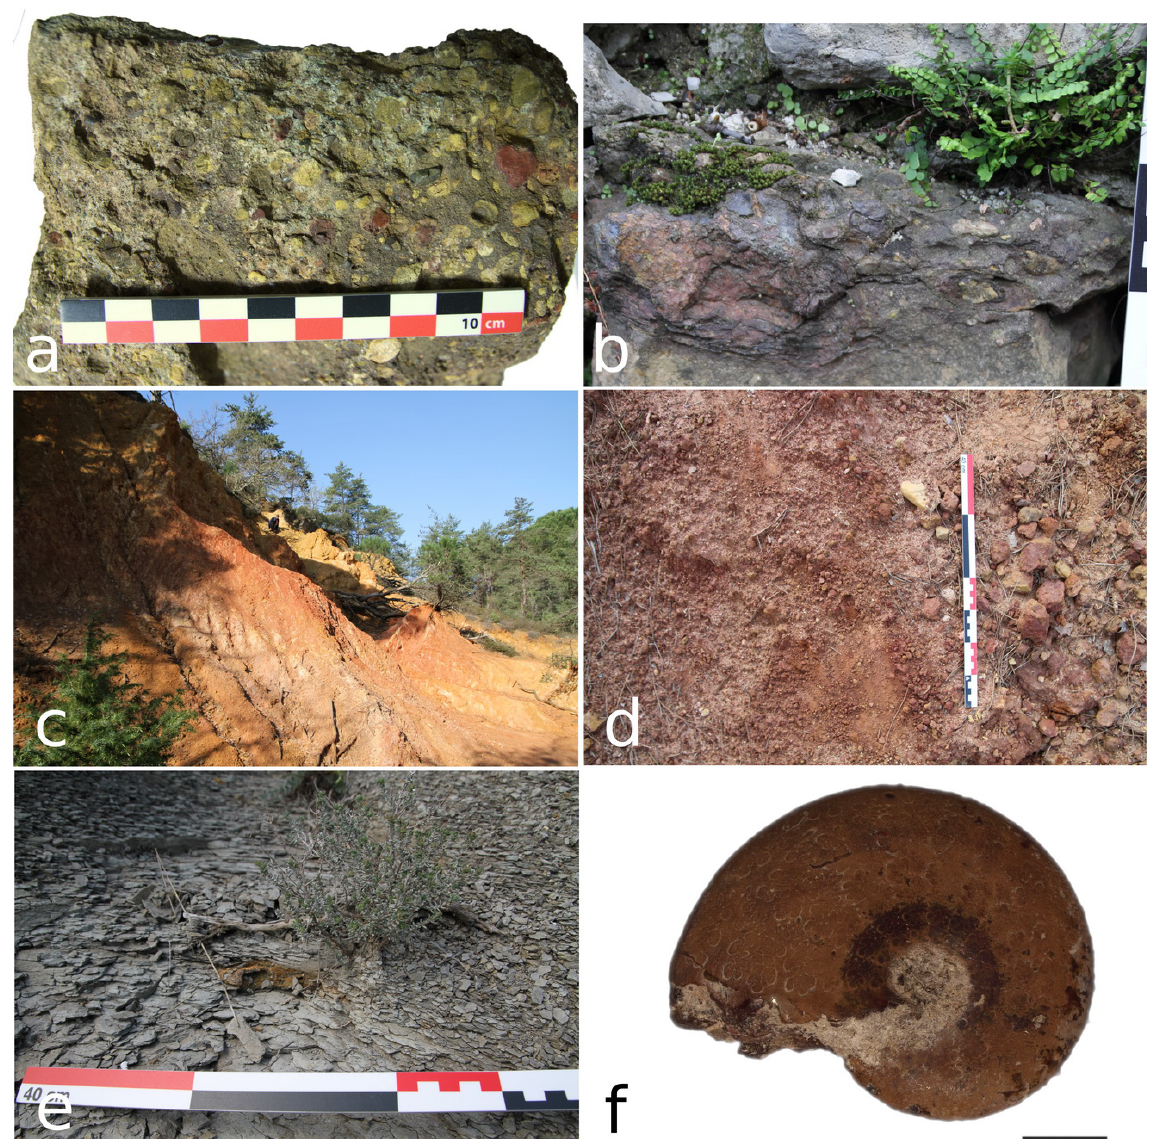
Figure 8. a) Puddingstone with pebbles of hematite and goethite, Campanian, La Moulinette, Hérault, France, b) 10 cm iron oxide-rich concretion, Les Vans, Ardèche, France, c-d) Weathering profile of a Lower Eocene fluvio- lacustrine sequence: ferruginous sand and sandstone, vallon de Fougeras, Dions, Gard, France, c) the outcrop is about 10 m high, e-f) Iron ox(hydrox)ide containing fossils derived from pyritised ammonites in liassic marls, Les Assions, Ardèche, France, e) ferruginous ammonite in marl deposits, f) isolated ferruginous ammonite (scale bar: 2 mm). Photos: a-e) H. Salomon, f) A. Chassin de Kergommeaux & H.